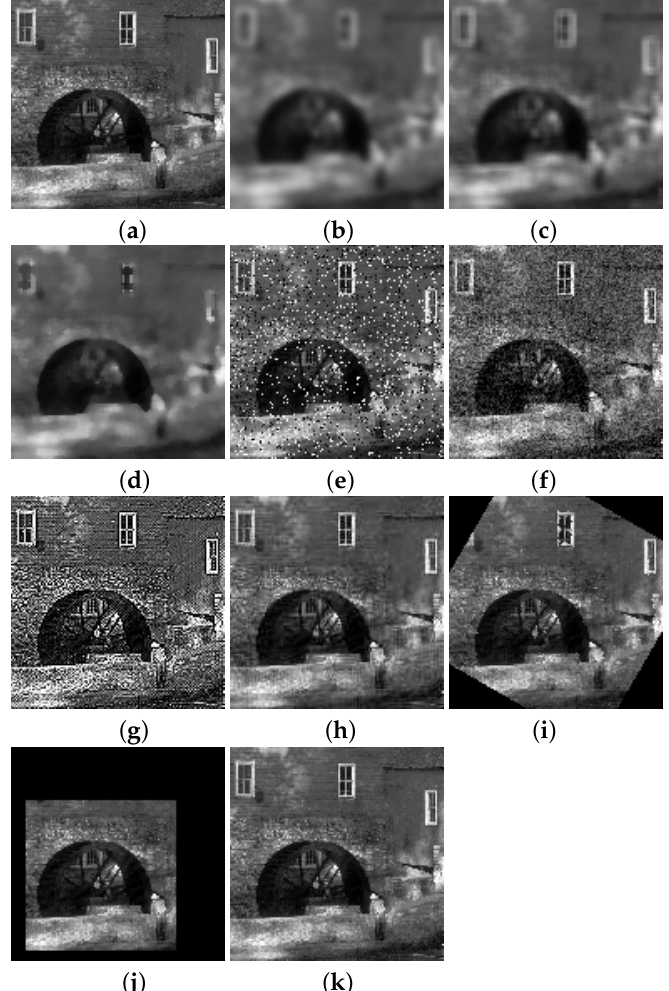
Figure 4. Examples of attacked images: ( a ) host image, ( b ) Gaussian filtering (9 × 9), ( c ) average filtering (5 × 5), ( d ) median filtering (5 × 5), ( e ) salt and pepper noise addition ( p = 0.1), ( f ) Gaussian noise addition (sigma = 0.1), ( g ) Laplacian sharpening (5-point stencil), ( h ) JPEG compression (quality factor = 50), ( i ) rotation (30 ◦ ), ( j ) crop ( p = 0.5), ( k ) dropout ( p =